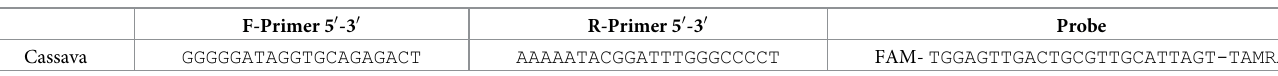
Table 1. Cassava gene primer